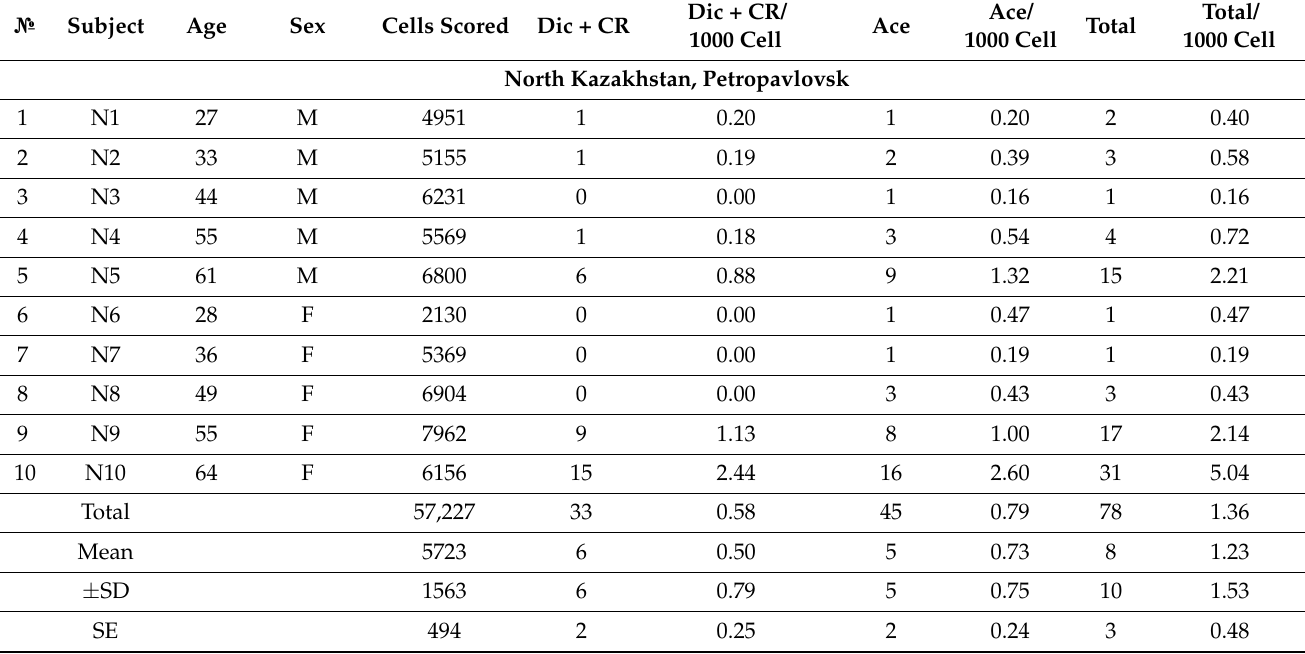
Table 1. Frequency of chromosome aberrations in control subjects from Kazakhstan